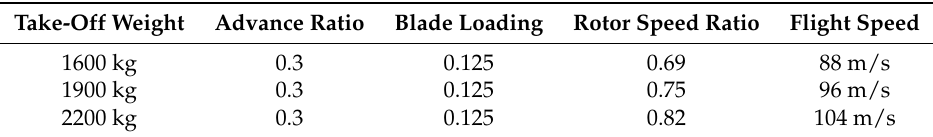
Table 4. Variable-speed rotor high loading case.